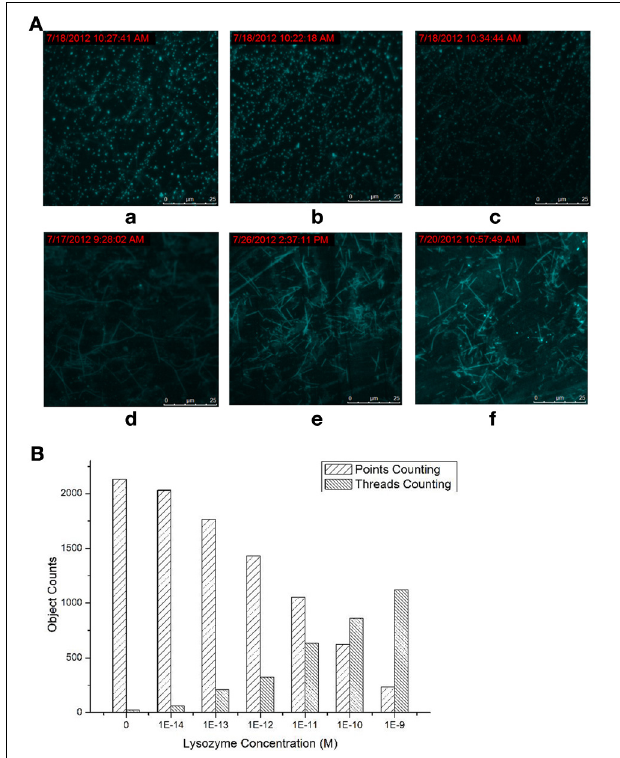
Figure 2 | Products of the molecular machine when different lysozyme concentrations were applied. (A) TIRFM visualization: (a) blank, (b)